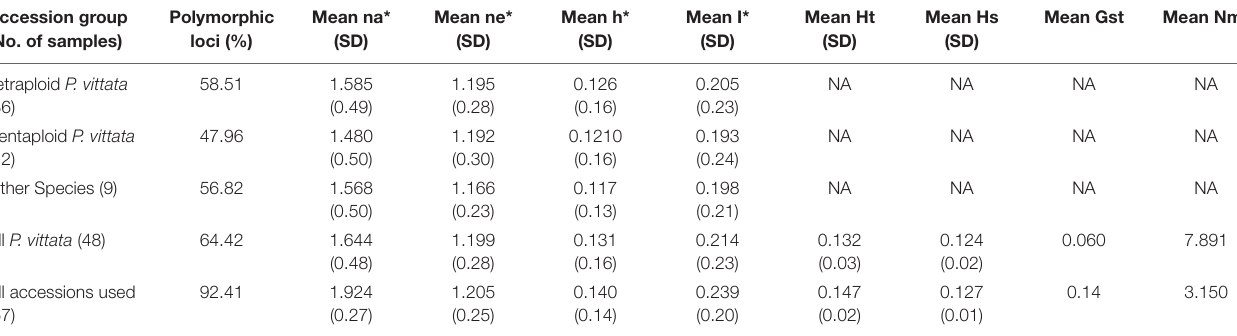
TABLE 8 | Analysis of “population” parameters for the cumulative band data for all accessions considered as groups of tetraploid, pentaploid, and other species accessions. Accession group (No. of